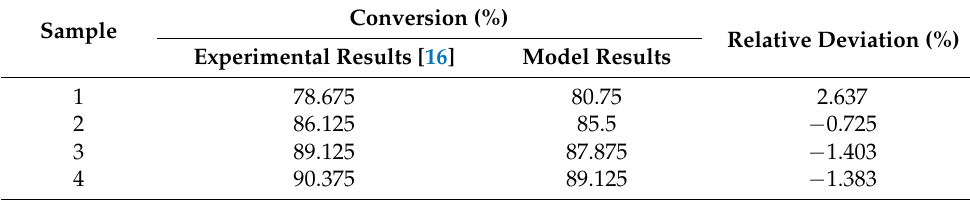
Figure 5. n -Butanol conversion as a function of ( a ) the residence time of the membrane reactor and ( b ) acetic acid/ n -butanol feed ratio. Figure 5b shows n -butanol conversion at different feed ratios of acetic acid to n -bu- tanol. It is evident that the increase in acetic acid to n -butanol feed ratio increases the n - butanol conversion. However, the increase in the feed ratio will eventually cause more problems during product purification. The flowrates of reaction species and n -butanol conversion as a function of reactor length are shown in Figures 6 and 7, respectively. The results obtained from the MR model were used in Aspen Plus to simulate the membrane reactor process, as described in the next section.